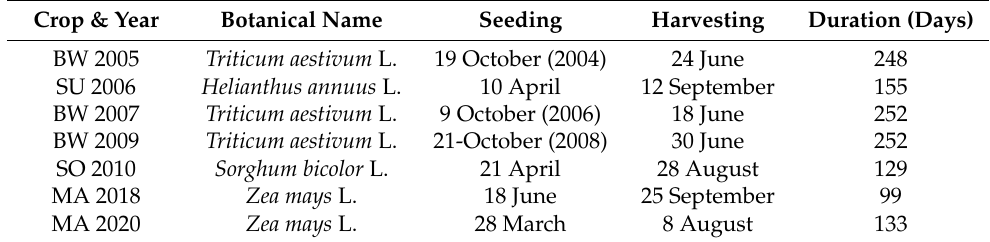
Table 1. Seeding and harvesting dates, and crop duration of cultivated crops.